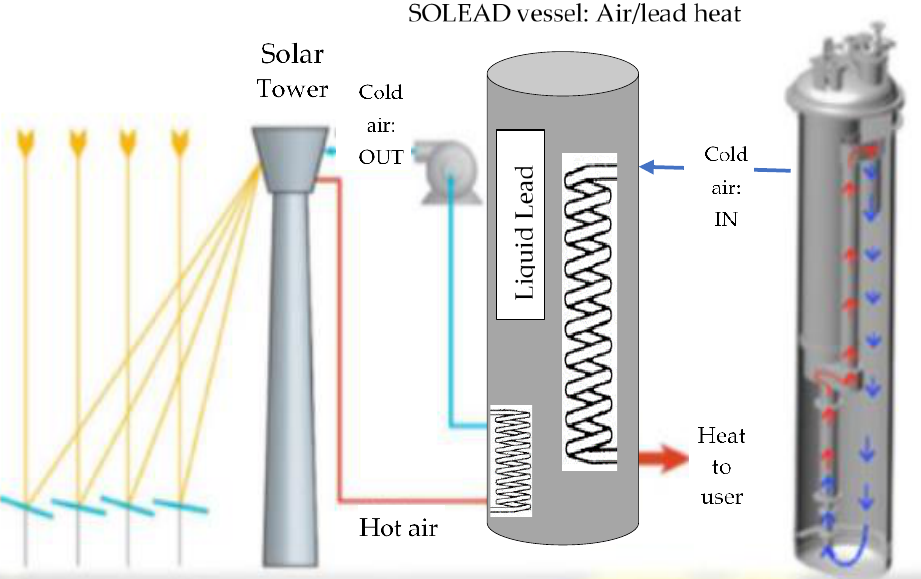
Figure 1. NEXTOWER system with the air/liquid lead (SOLEAD) heat exchanger, detailed on the right.